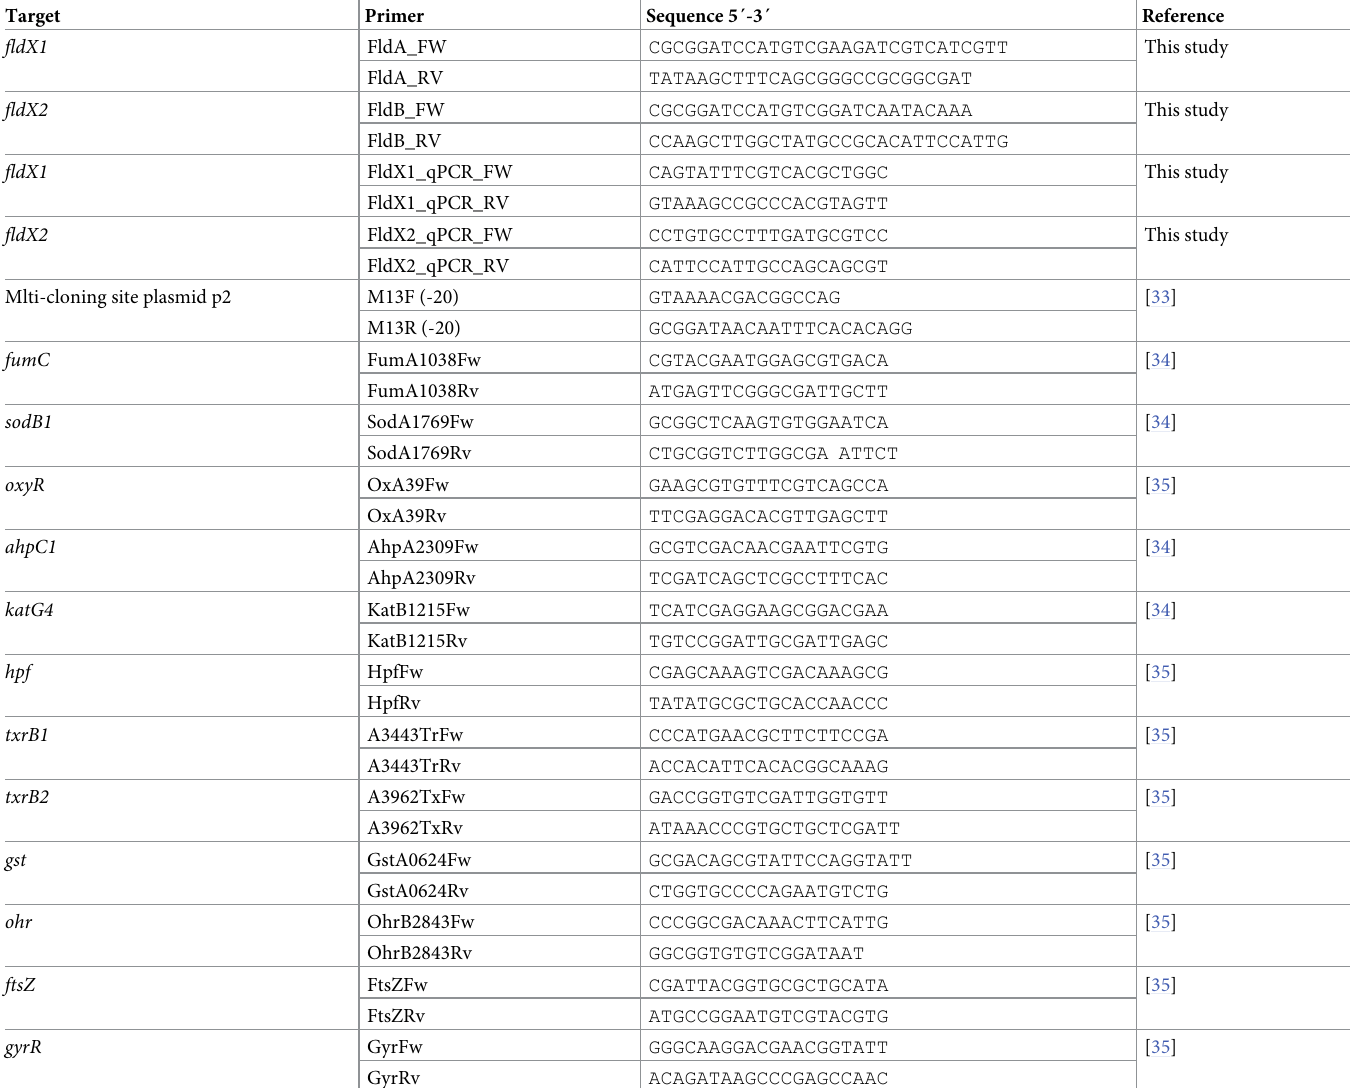
Table 1. Oligonucleotides used as primers in this